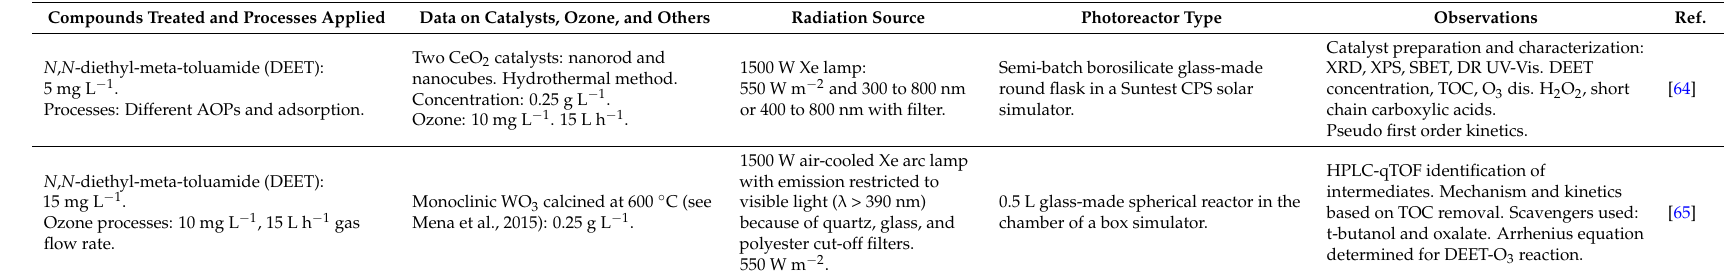
Table 2. Cont. Compounds Treated and Processes Applied Data on Catalysts, Ozone, and Others Radiation Source Photoreactor Type Observations Two CeO 2 catalysts: nanorod and nanocubes. Hydrothermal